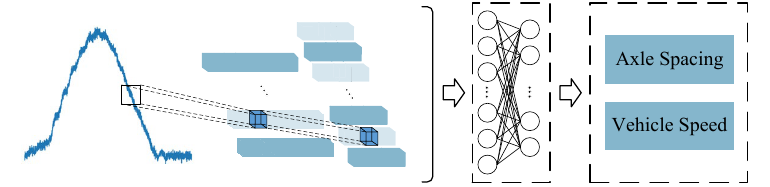
Figure 1. Framework of the velocity and wheelbase identification.